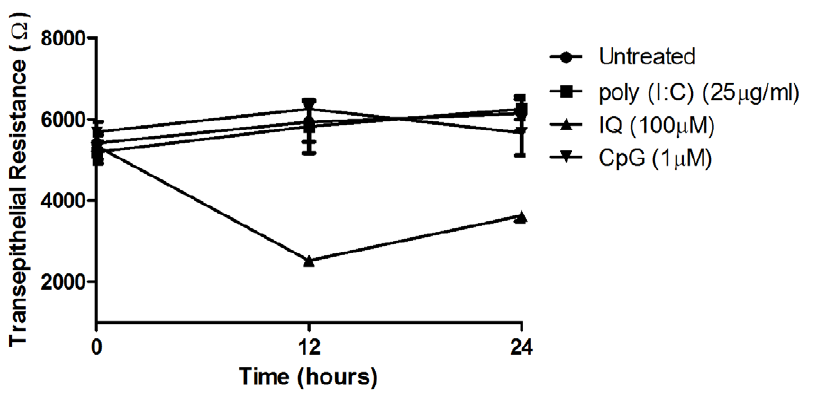
Figure 1. Imiquimod transiently decreases transepithelial resistance in ECC-1 cells. ECC-1 cells ( representative of three independent experiments ) were cultured on cell inserts until confluent and then apically stimulated with poly (I:C) (TLR3), IQ (TLR7/8) and CpG (TLR9) at the concentrations shown above. TER measurements were taken at 12 and 24 hours post-stimulation. Results are shown as the mean + / 2 SEM.